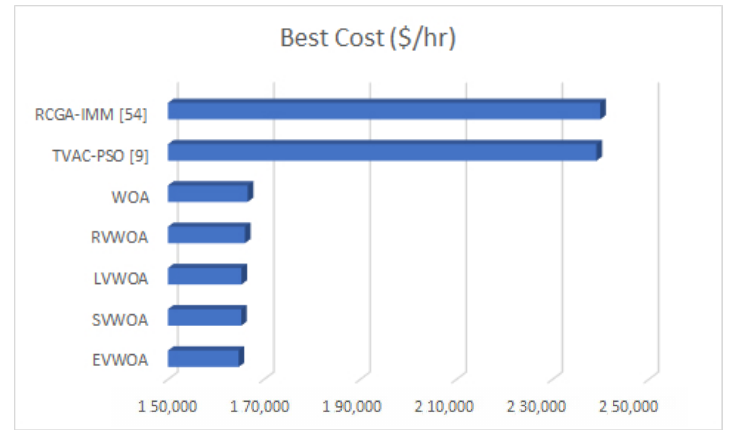
Figure 14. Best Cost Comparison for Case Study